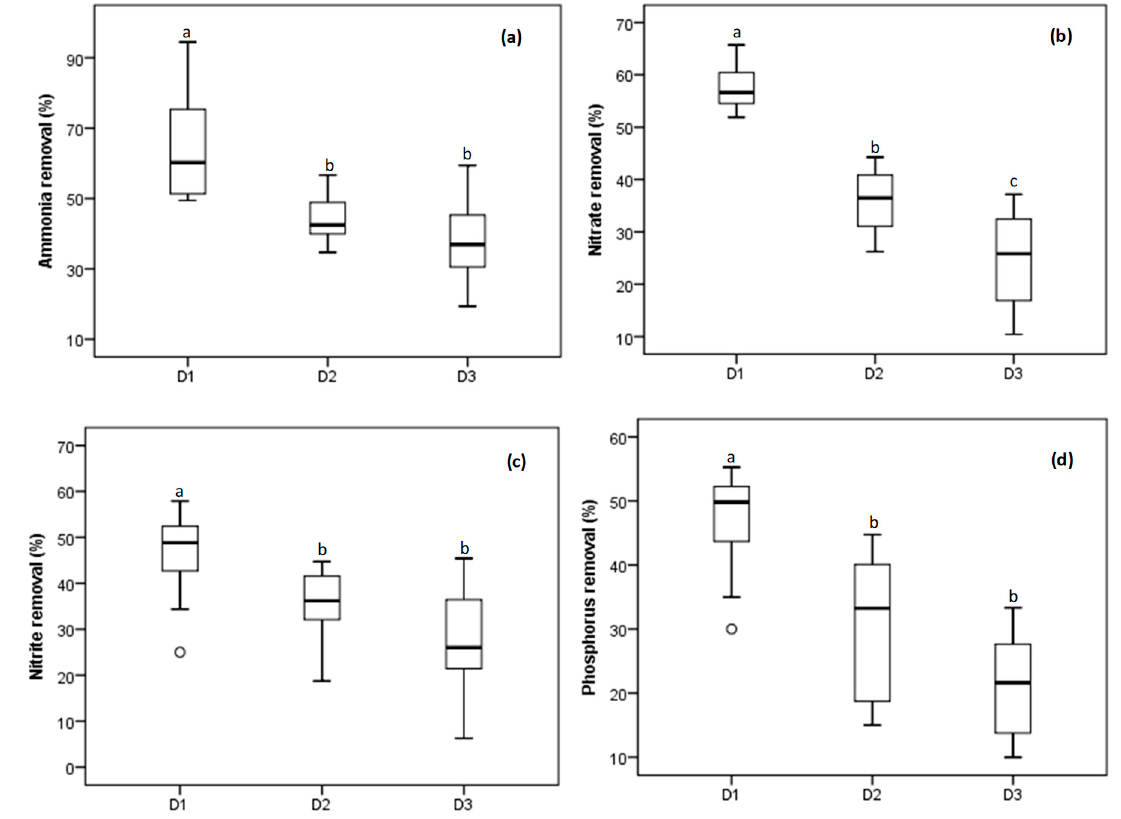
Figure 3. Ammonia ( a ), nitrate ( b ), nitrite ( c ), and phosphorus ( d ), removal e ffi ciency (%) of di ff erent plant densities in the aquaponic system. D1 represents 48 plants / m 2 , D2; 24 plants / m 2 and D3; zero Figure 3. Ammonia (a) , nitrate (b) , nitrite (c) , and phosphorus (d) , removal efficiency (%) of different plants / m 2 (control). Di ff erent letters above boxplots indicate significant di ff erences between density plant densities in the aquaponic system. D1 represents 48 plants/m 2 , D2; 24 plants/m 2 and D3; zero treatment (one–way ANOVA) ( p < plants /m 2 (control). Different letters above boxplots indicate significant differences between density treatment (one–way ANOVA) (p < 0.05).